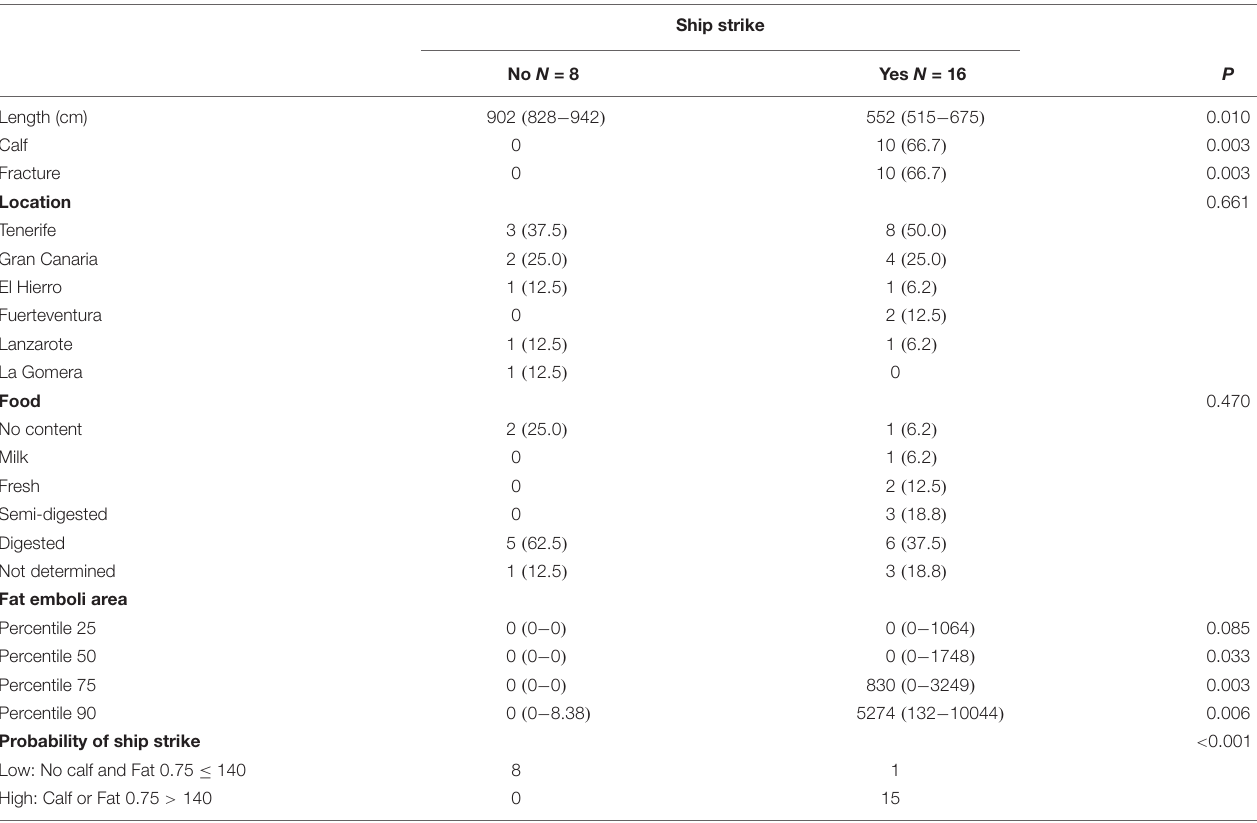
TABLE 3 | Categorical variables studied expressed as frequencies and percentages or continuous, expressed as medians and interquartile ranges (IQR = 25th–75th